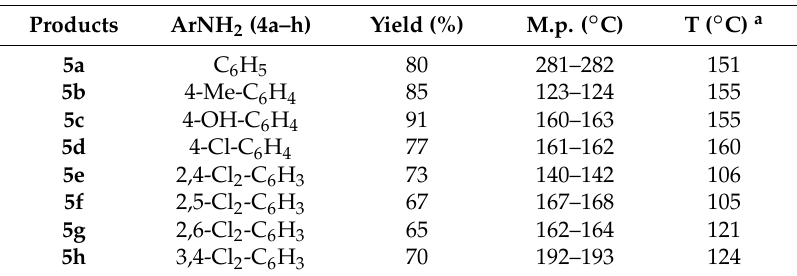
Table 2. Impact of aniline structure on reaction yield.